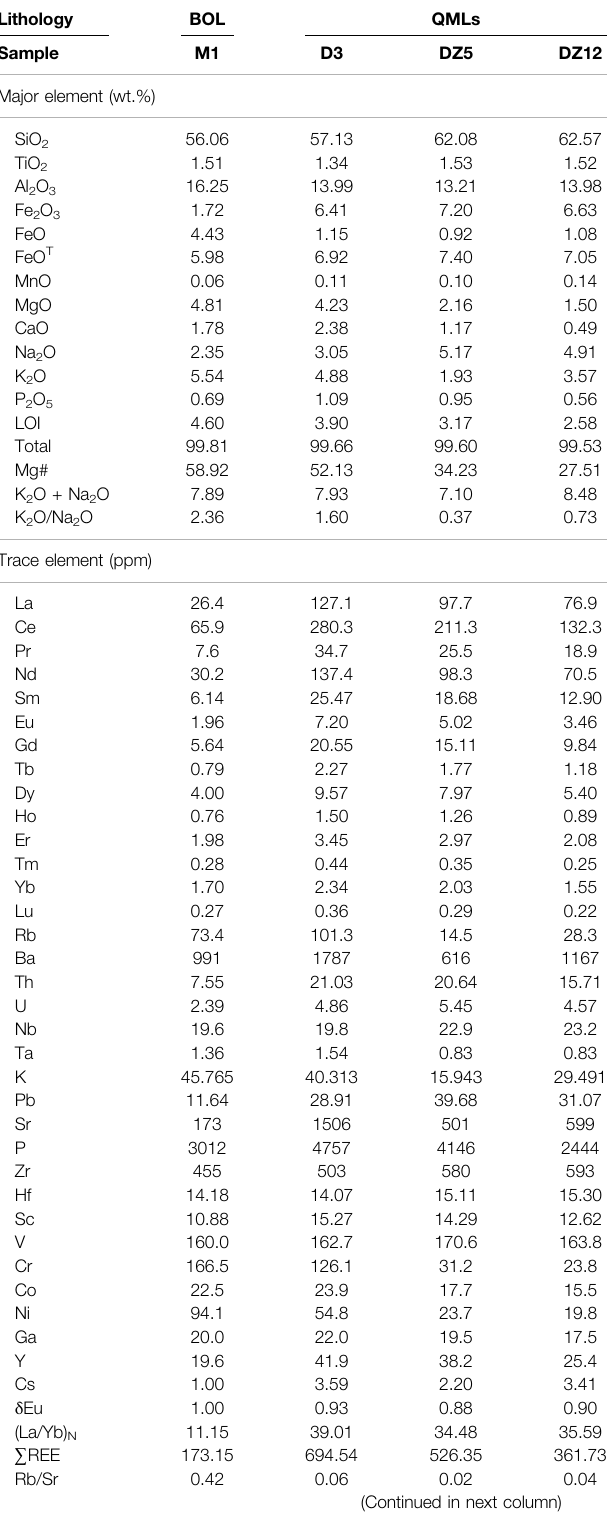
TABLE 3 | Major (wt.%) and trace element (ppm) compositions of the